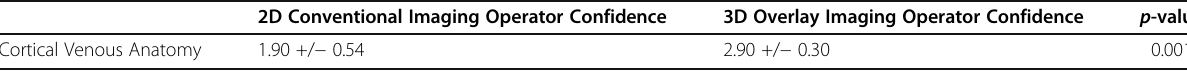
Table 1 Operator Confidence Levels in 3D Overlay versus 2D Conventional Imaging 2D Conventional Imaging Operator Confidence 3D Overlay Imaging Operator Confidence p